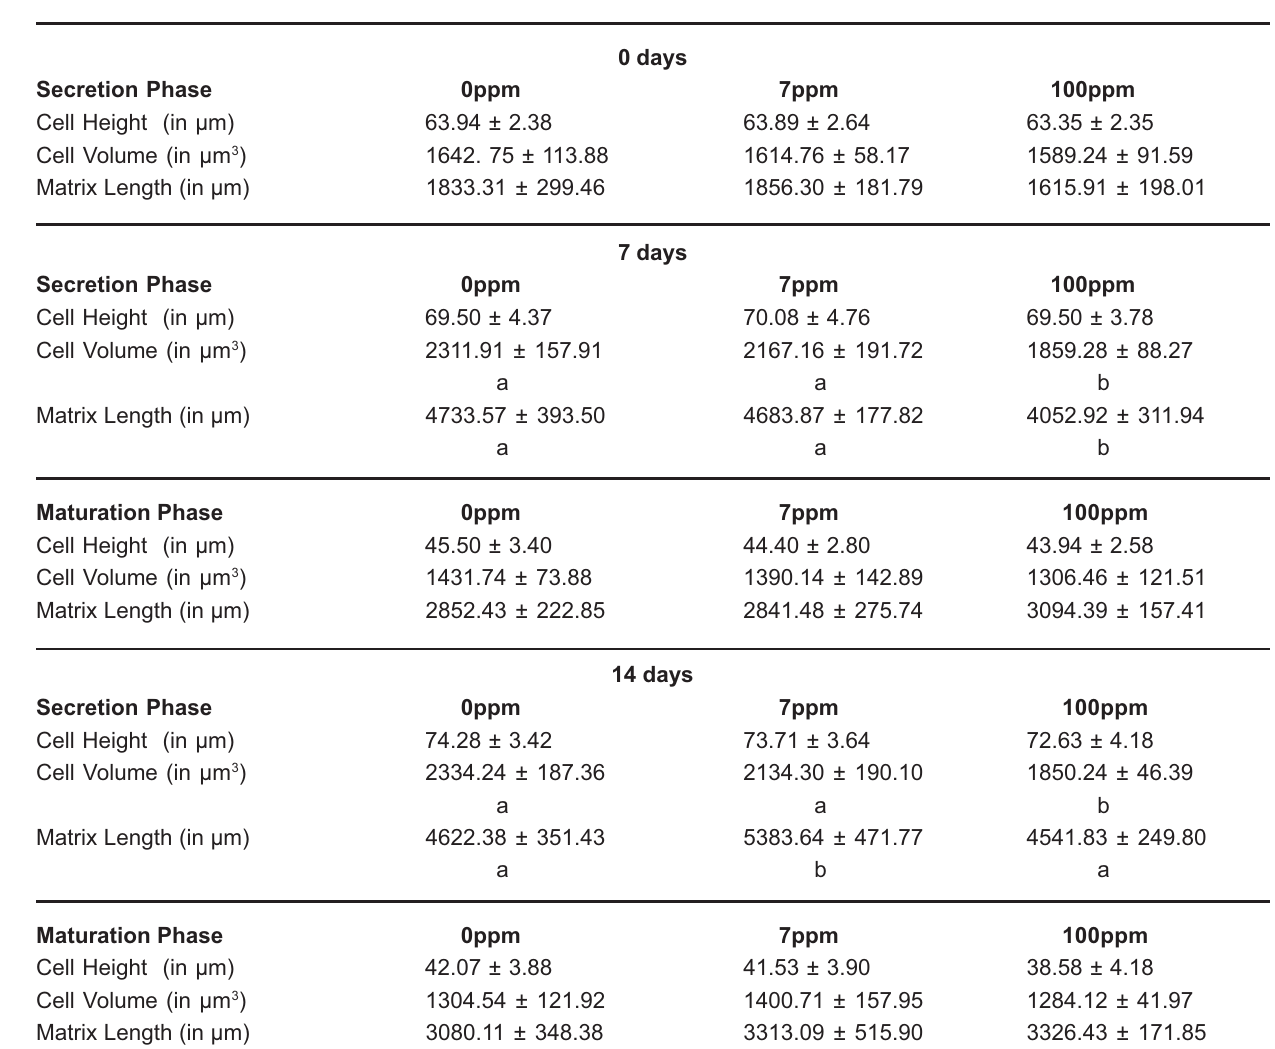
TABLE 1- Means and standard deviation of morphometric parameters from groups of 0, 7 and 14 days of postnatal life